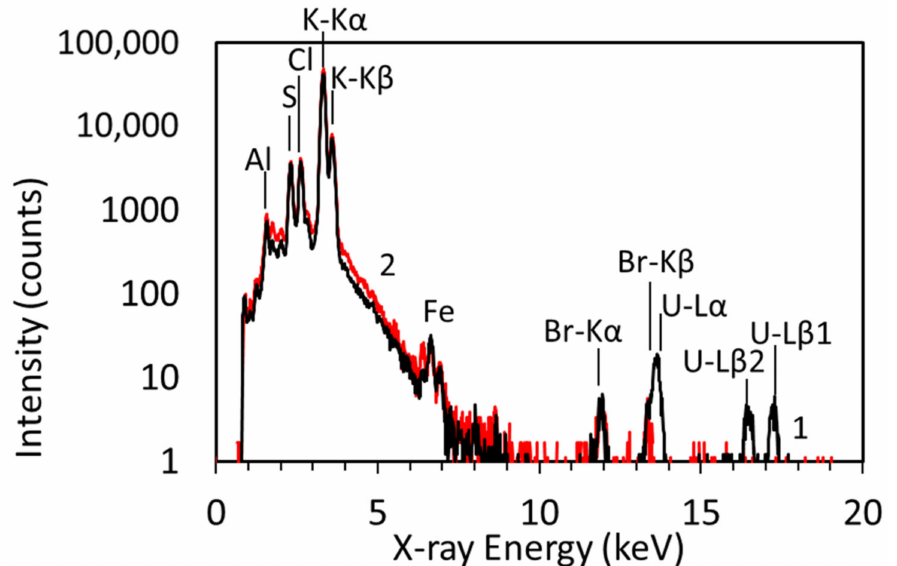
Figure A1. µ -PIXE spectra of specimens prepared using 1 µ L droplet of mixed solutions of urine treated with five-fold by HNO 3 containing 50 µ g/g U for curve 1 (black line) and that without U for curve 2 (red line). Si(Li) detector was used for the